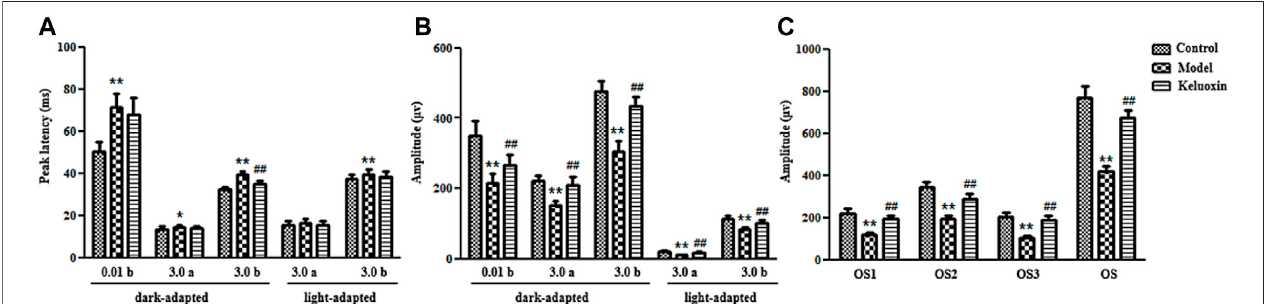
FIGURE 3 | ERGs of the control, model, and KLX-treated groups. (A) Peak latencies of b-wave of dark-adapted 0.01 ERG, a-wave of dark-adapted 3.0 ERG, b-wave of dark-adapted 3.0 ERG, a-wave of light-adapted 3.0 ERG, and b-wave of light-adapted 3.0 ERG. (B) Amplitudes of b-wave of dark-adapted 0.01 ERG, a-wave of dark-adapted 3.0 ERG, b-wave of dark-adapted 3.0 ERG, a-wave of light-adapted 3.0 ERG, and b-wave of light-adapted 3.0 ERG. (C) Amplitude of Ops of dark-adapted3.0 ERG.Valuesarepresentedasmean±SEM( n =10pergroup).DatawereanalyzedbyStudent ’ s t -test.Modelgroupwascomparedwithcontrol group; * p < 0.05, ** p < 0.01. KLX-treated group was compared with model group data; # p < 0.05. ERG, electroretinography; KLX, keluoxin; Ops, oscillatory potentials.